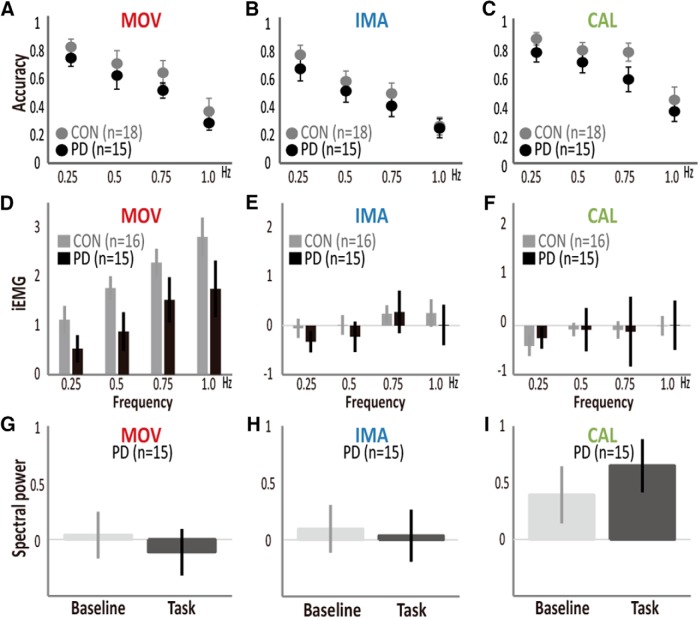
Behavioral and EMG findings in participants with PD (black) and controls (light gray). During the fMRI experiment, accuracy in the movement (MOV; A), imagery (IMA; B), or calculation (CAL; C) task did not differ between the participants with PD (n = 15) and controls (n = 18). See Extended Data Figure 7-1 for the statistical values. D, Compared with healthy senior participants (n = 16; data were not available from two controls due to technical problems), participants with PD (n = 15) showed iEMG activity (arbitrary units) responding to the movement rate to a similar degree. iEMG did not show GROUP-by-rate interactions during the imagery (E) or calculation task (F). Power spectral analysis (4-8 Hz) of EMG data (arbitrary units) in participants with PD (n = 15) in the movement (G), imagery (H), and calculation (I) tasks. No differences in the EMG spectral power were found between the task and rest periods, suggesting that tremor did not change in the task condition. Error bars: SEM.